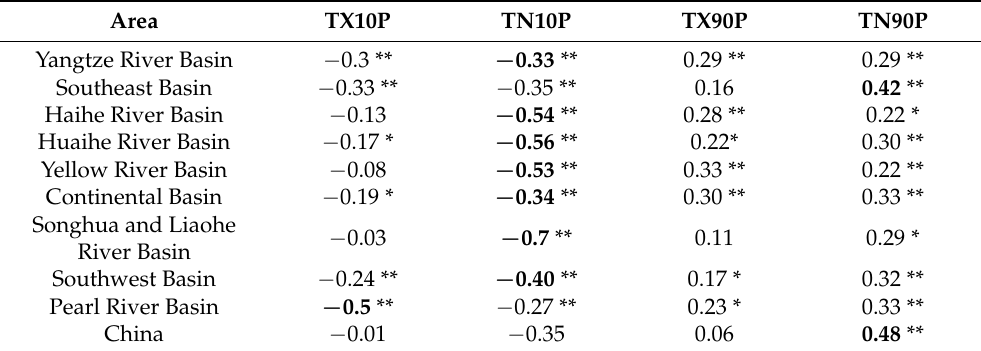
Table 3. Standard regression coefficient between extreme temperature events and T mean in different basins in mainland China from 1961 to 2013 based on observation